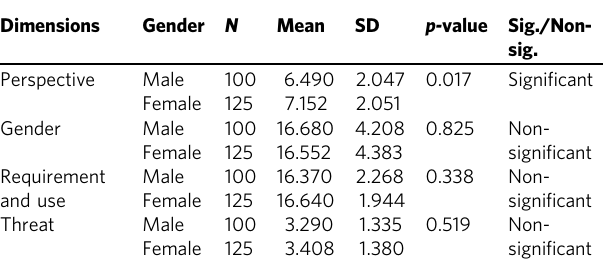
Table 3 Mean, SD and p -values on different dimensions of AI robots ( N = 225) (t-test) (alpha is set to the default 0.05).